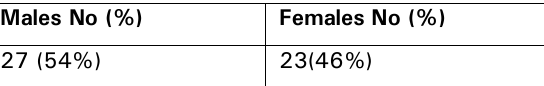
Table 4: Sex wise